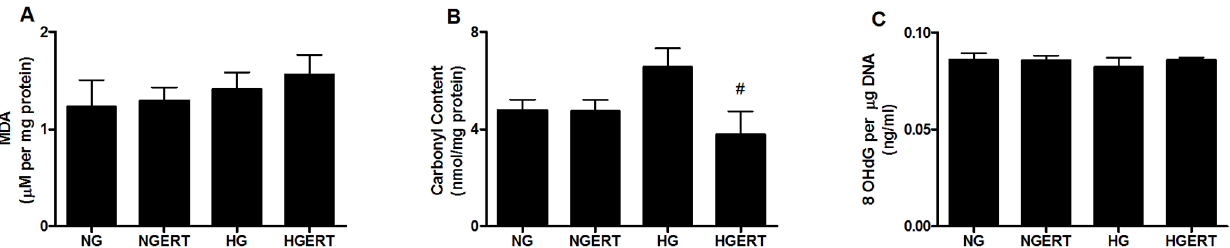
Figure 2. Effect on oxidative stress parameters. Effect of pre/co incubation with 5 mM erythritol (ERT) on HUVECS cultured in normal glucose (NG, 7 mM) or high glucose (HG, 30 mM) for 24 hours on malondialdehyde (A), carbonyl (B) and 8-OHdG (C) content. Data are expressed as means 6 standard error of three independent experiments. # =p , 0.1 compared to HG. changed in response to HGERT vs. HG (HGERT/HG; p , 0.05).